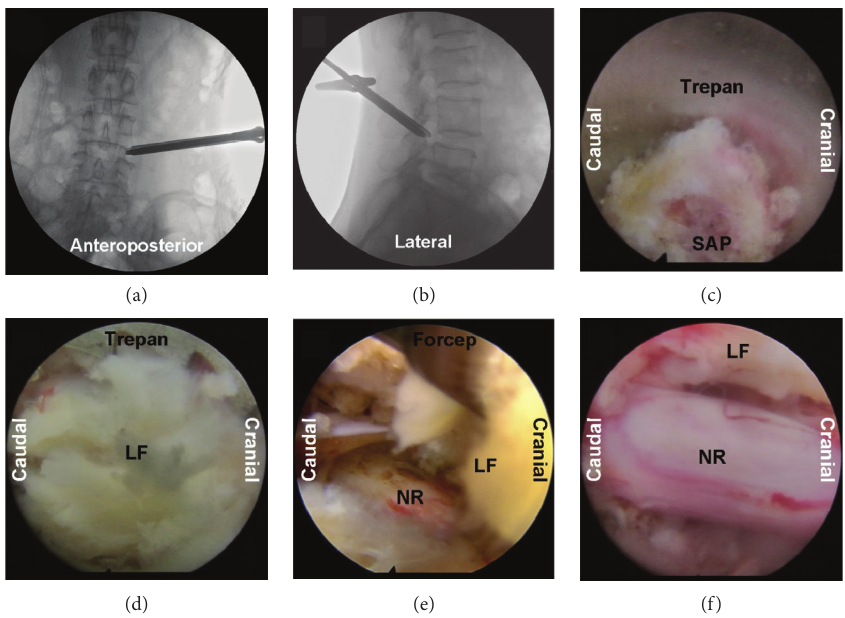
Figure 1: Intraoperative images of PELD of a case at L4-5 with “U” route PELD. The location of the working channel using fluoroscopy is showing in (a) anteroposterior and (b) sagittal. (c) The SAP was removed with a trepan for foraminoplasty. (d) The endoscopic image when trepan was introduced for posterior LF resection for dorsal decompression. (e) The forceps was introduced to remove dorsal LF. (f) Dorsal and ventral LF of the L5 nerve root was fully decompressed. SAP � superior articular process, LF � ligamentum flavum, and NR � nerve root.